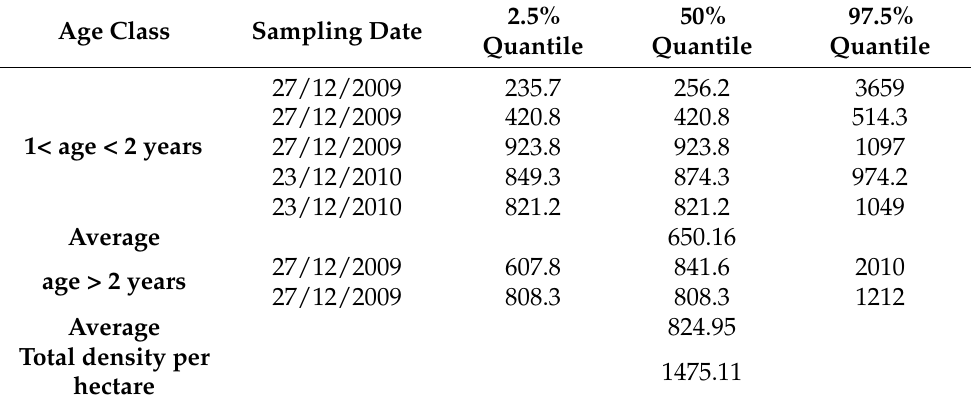
Table A2. Density Estimates for the Clar é e population. The density estimates are provided as the number of fish per hectare. Three different sites were selected and sampled in 2009, and two of them were revisited for sampling in 2010. Fish older than 2 years old were too rare in 3 samplings to safely estimate density, and were thus not accounted for.